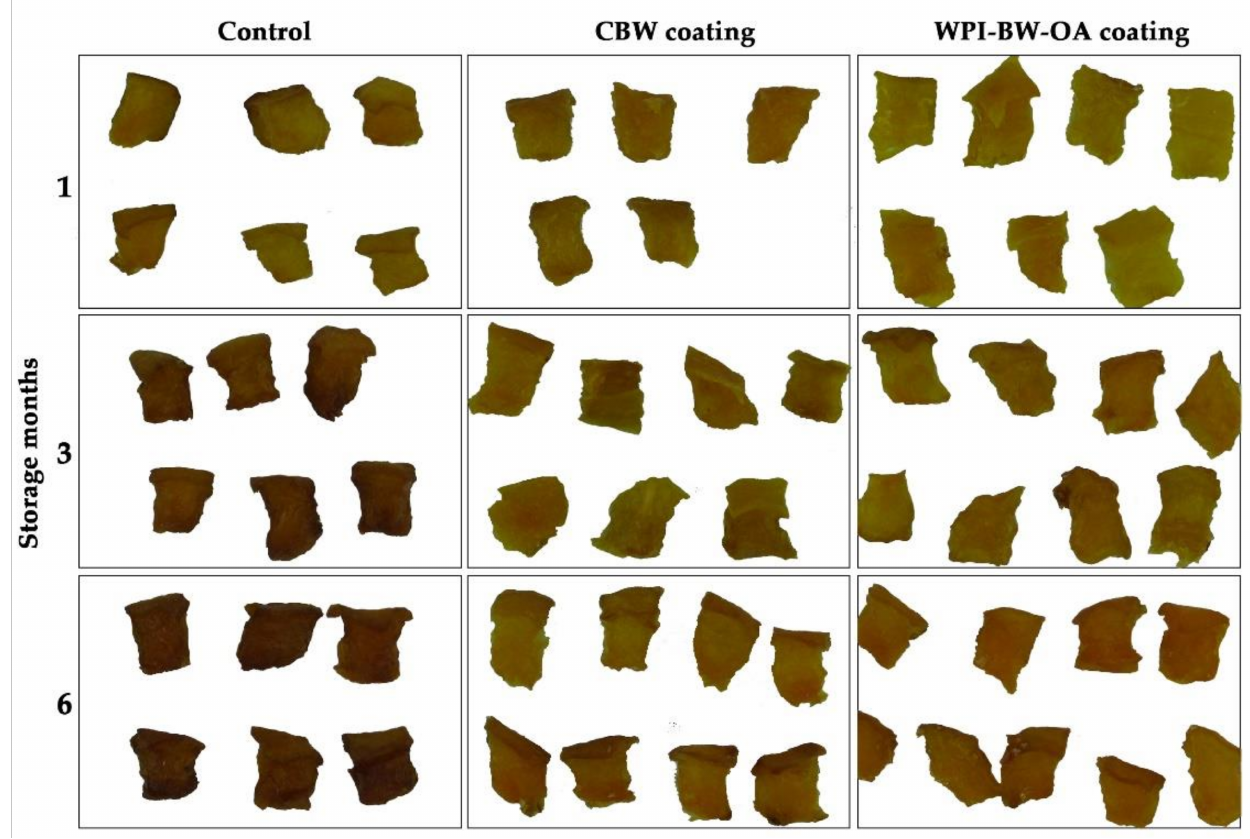
Figure 2. Images of uncoated (control) and WPI-BW-OA- and CBW-coated samples during storage time (only Months 1, 3 and 6 are shown here). Samples for imaging were randomly selected from the apricot-cornflake mix system during storage times. The background of images was set in white for better clarity of color